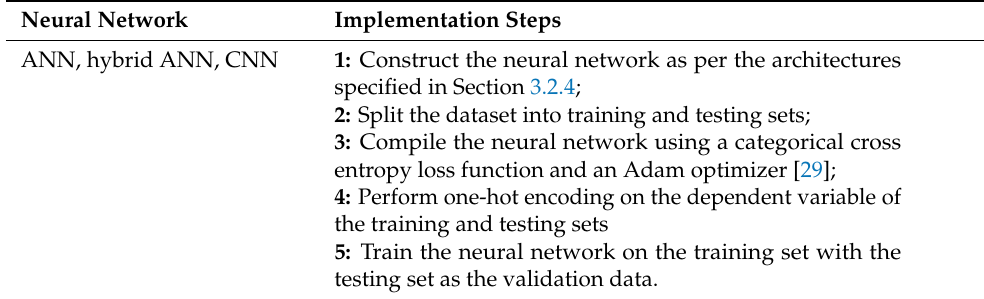
Table 7. Deep-learning